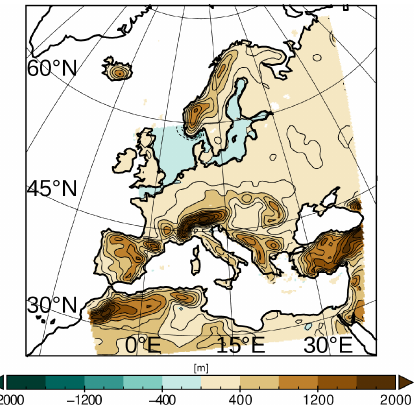
Figure 1. Model domain showing the land topography of the RCA climate model (in shades of brown). Bathymetry information is within the domain of the interactively coupled ocean model NEMO (in shades of